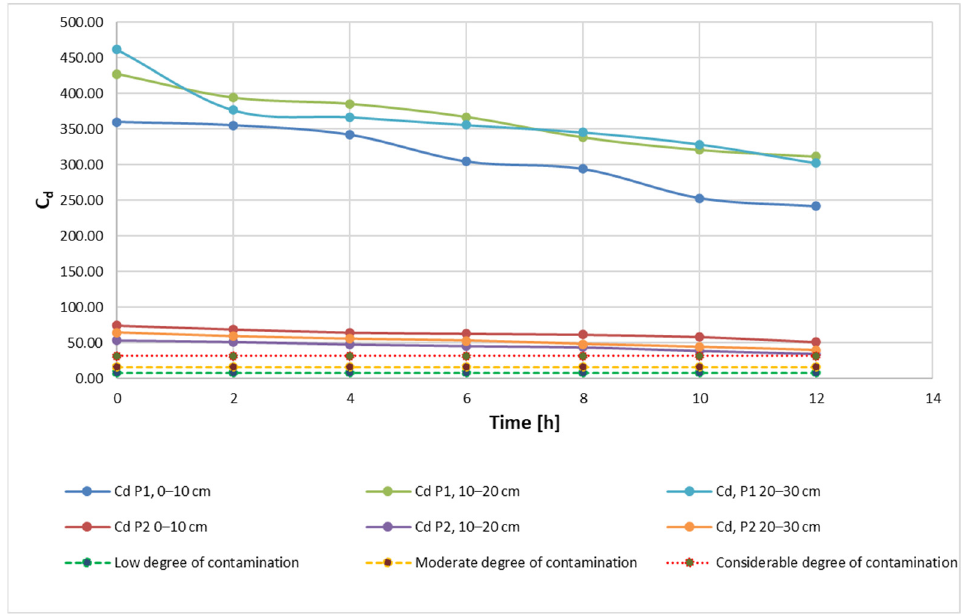
Figure 3. Parameters calculated for the initial concentration: ( a ) C d —degree of contamination; ( b ) E r —environmental risk index; ( c ) PLI—pollution loading index; and ( d ) PERI—potential environmental risk index.